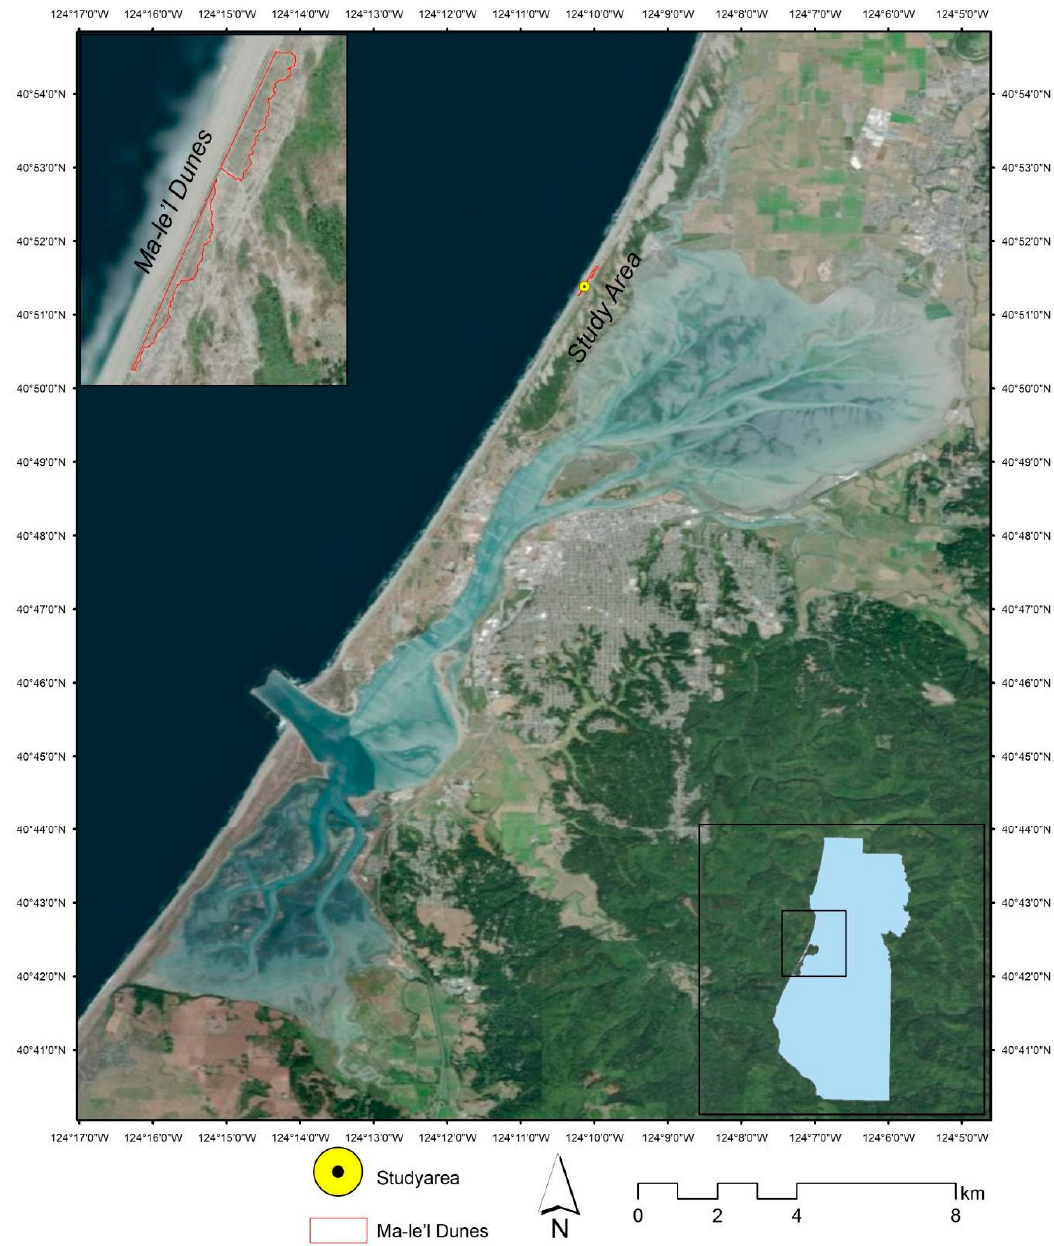
Figure 1. Locator map of the study area at the Friends of the Dunes in Manila near Humboldt Bay Area, CA.